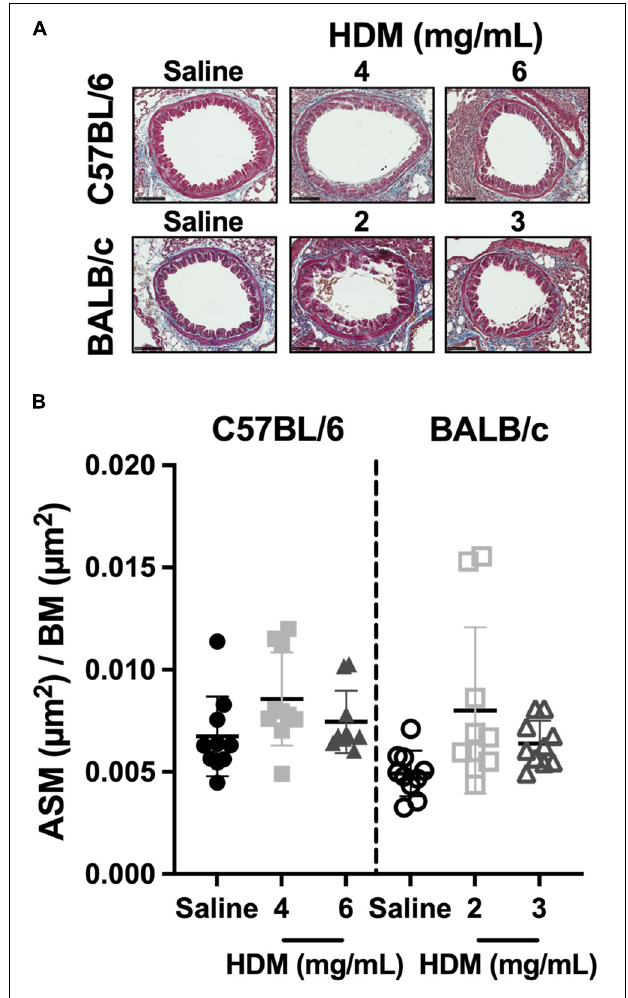
FIGURE 6 | The content of smooth muscle within the airway wall. The images in (A) show representative lung sections from C57BL/6 (upper panels) and BALB/c (lower panels) mice exposed to incremental doses of house dust mite (HDM) (from left to right). The scale bar is 100 µ m. For each bronchus analyzed, the area occupied by the airway smooth muscle (ASM) was divided by the square of the basement membrane (BM) perimeter and average results for each mouse in all groups are presented in the scatter plot shown in (B) . Data are shown as means ± SD. n = 10 mice per